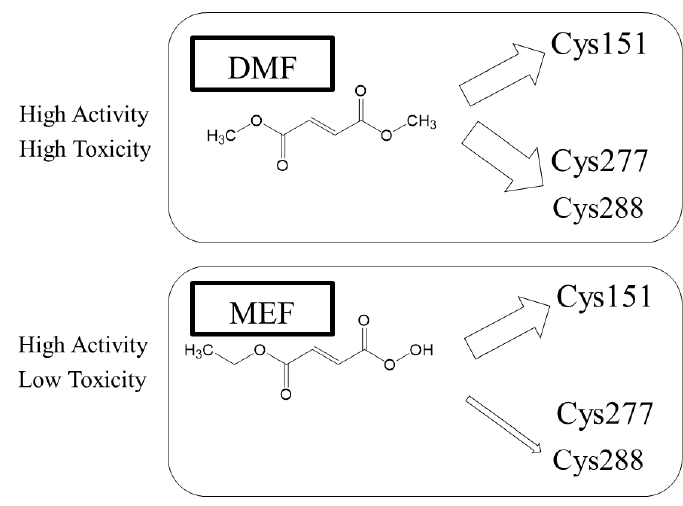
Figure 1. DMF and MEF modulate distinctive repertoires of cysteine thiols on KEAP1. Although DMF reacts with many cysteine residues, including Cys151, Cys273, and Cys288, MEF appears to react preferentially with Cys151. DMF has proven to be more toxic than MEF, although DMF and MEF both activate NRF2, at least in vitro 35,36 . DMF, dimethyl fumarate; KEAP1, Kelch-like ECH-associated protein 1; MEF, monoethylfumarate; NRF2, nuclear factor erythroid 2-related factor